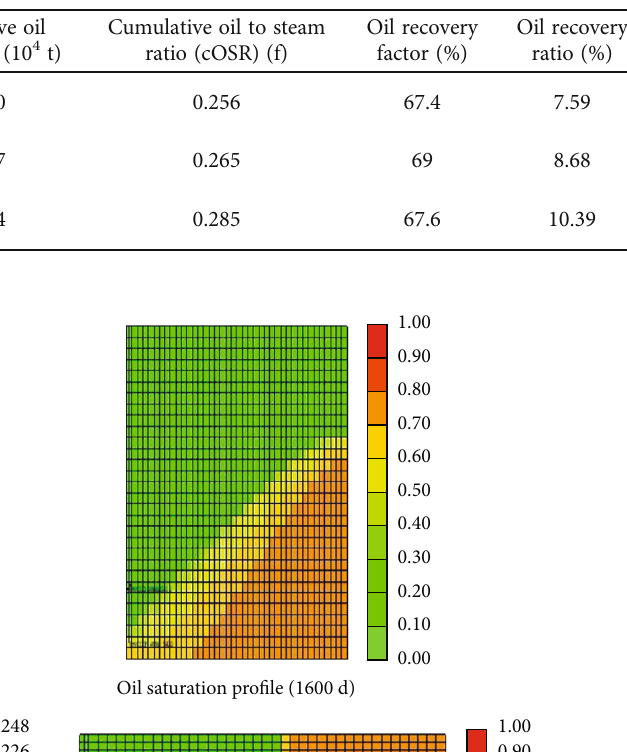
Table 3: Comparison of the production characteristics of model